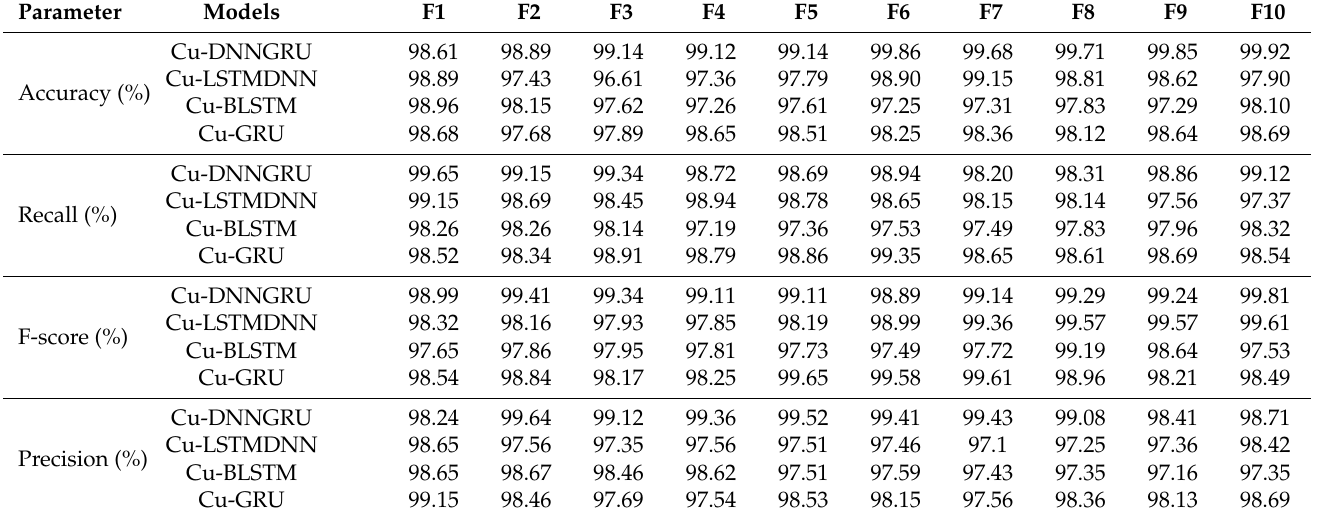
Table 6. Cross-validation results.